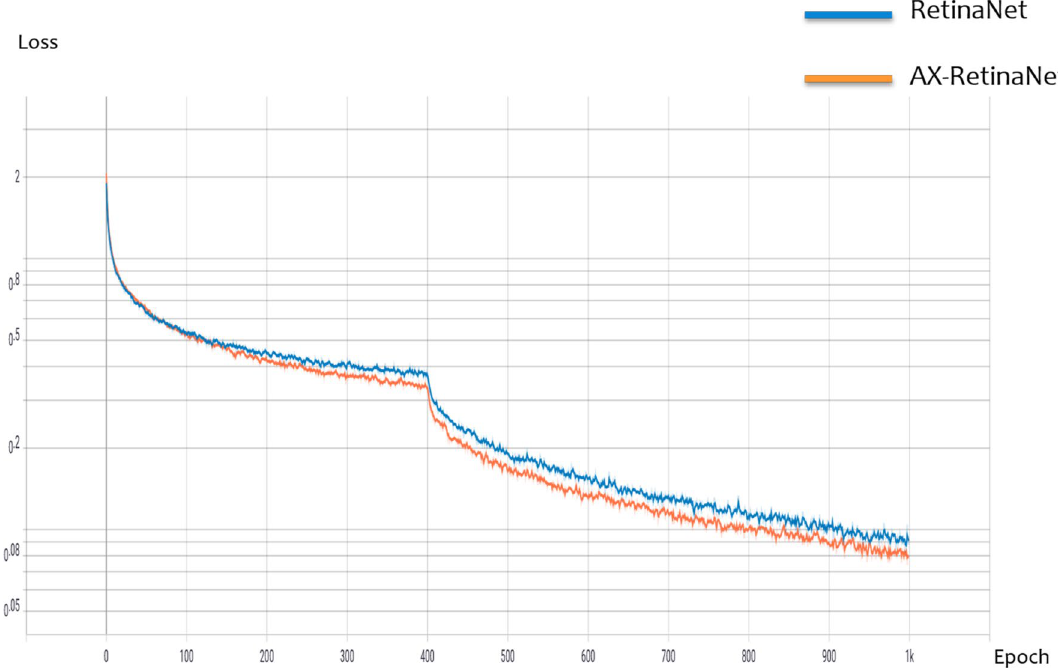
Figure 11. Loss curve of AX-RetinaNet and RetinaNet during training.